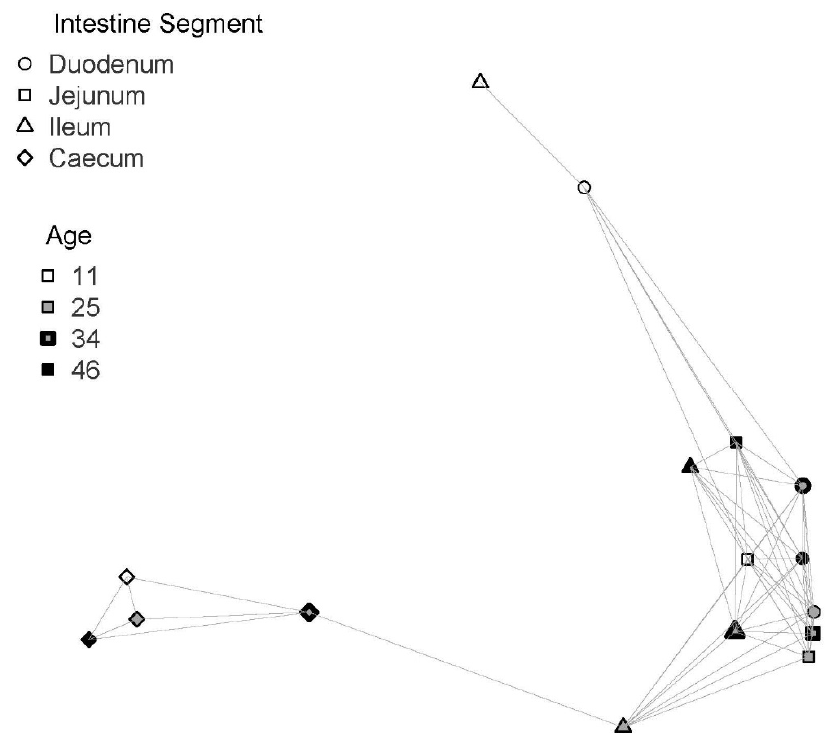
Figure 6. Network analysis showing the associations between intestine segments and ages in the gut microbiota of chick- ens.